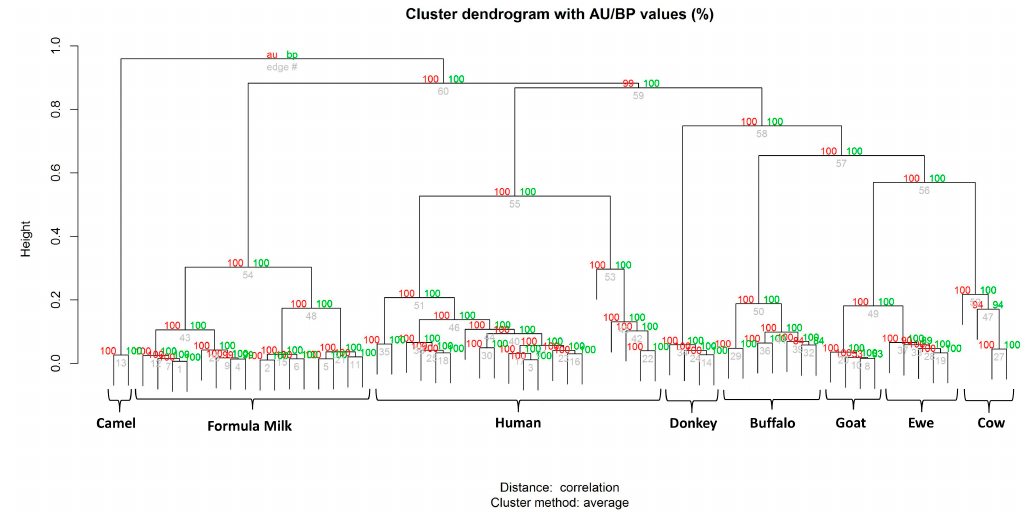
Figure 5. Hierarchical clustering tree (bootstrap n = 1000) of all MALDI-TOF spectral replica from animal milk (CM, BM, GM, EM, DM, and CAM), human milk at 2, 30, 60 and 90 days (HC, HM30, HM60 and HM90, respectively), and infant formula (A, F, H, N). Red values (left) are approximately unbiased (AU) p -values, green values (right) are bootstrap probability (BP) values, and grey values are cluster labels (bottom).